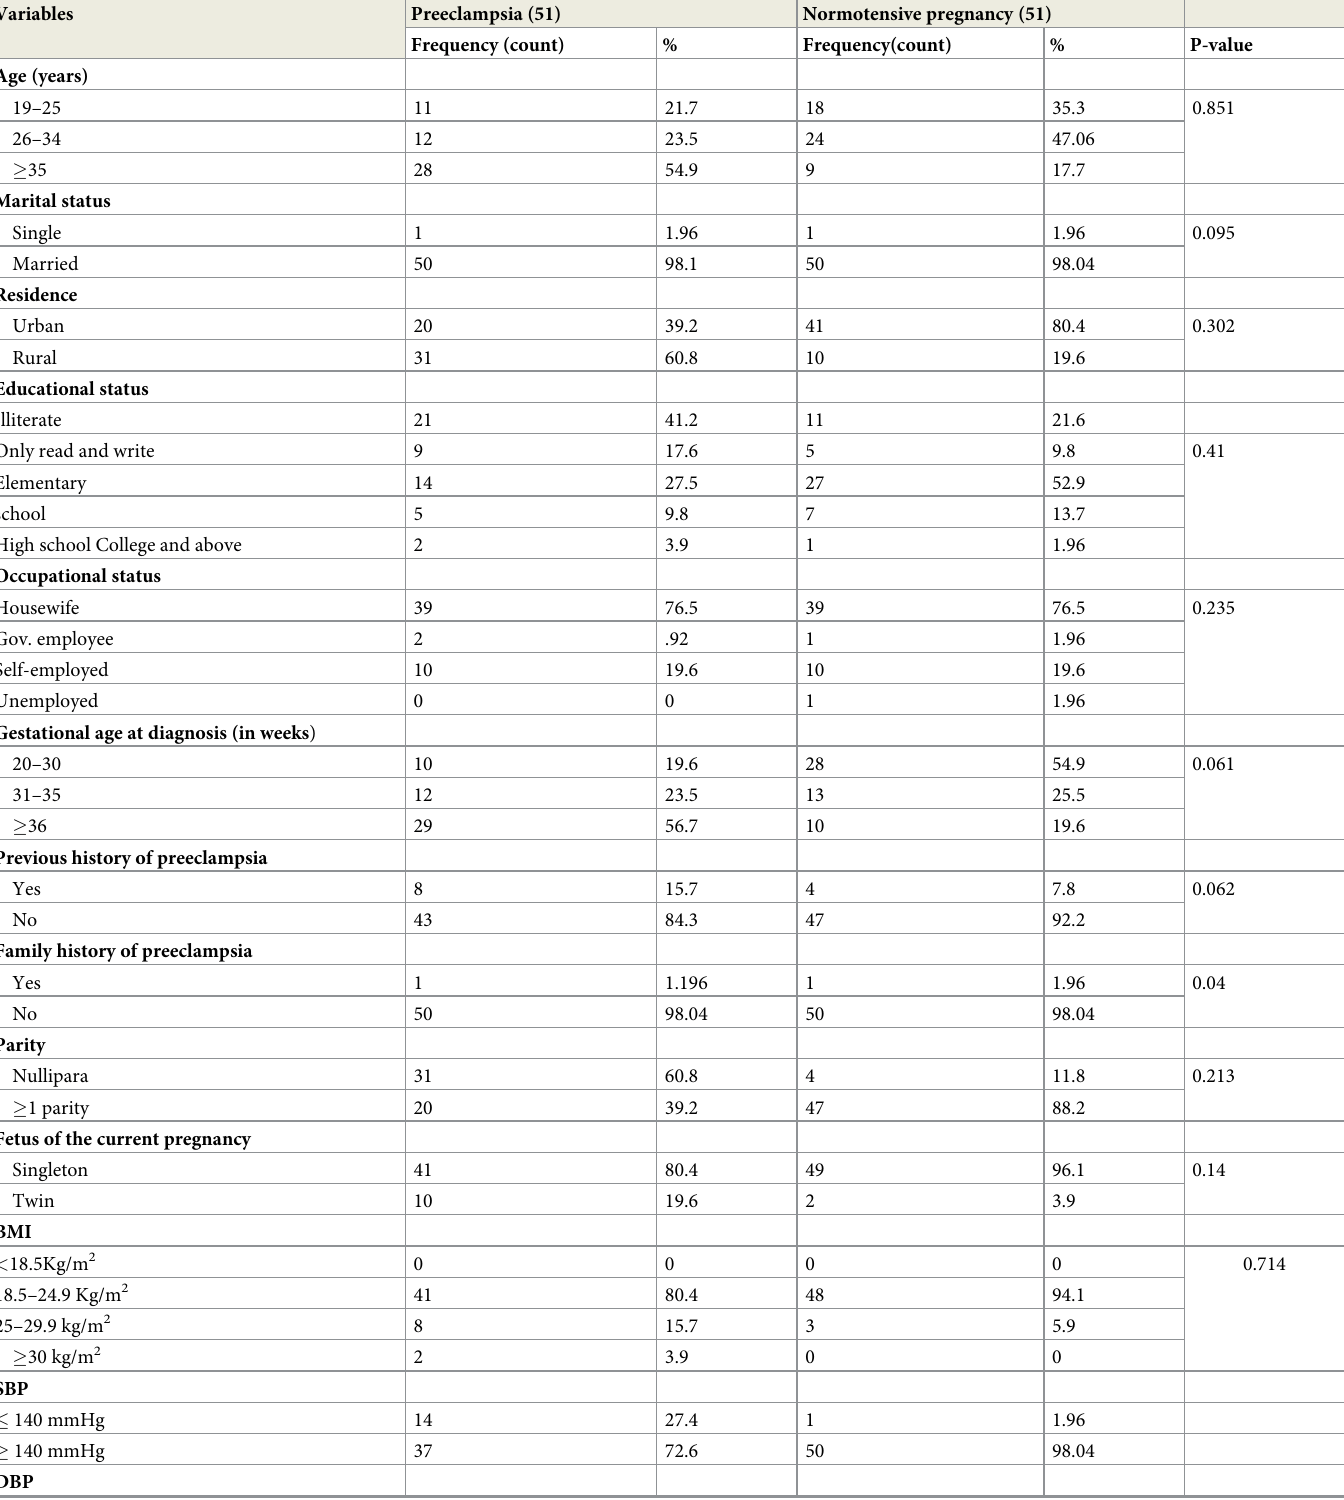
Table 1. Baseline characteristics of study participants, University of Gondar Comprehensive Specialized Hospital, Northwest Ethiopia,